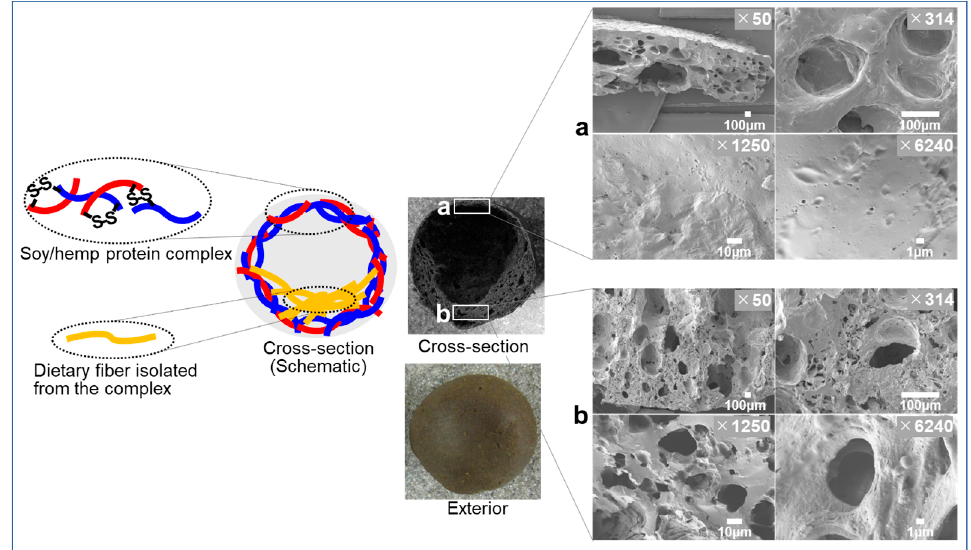
Figure 3. A “roly-poly” wiggle ball made from soy/hemp protein complex. ( a ), protein-rich outer shell; ( b ), fiber-rich inner bottom part. Reprinted/adapted with permission from Ref. [74]. Copyright 2022, NARO.